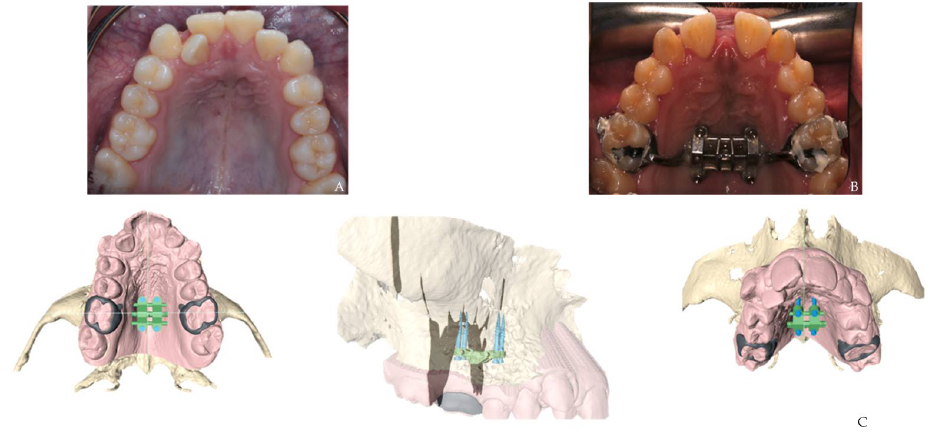
Figure 4. Planning the placement of micro-implants in the maxillary expander: Initial occlusal photo ( A ). Placement of the microimplant assisted rapid palatal expander ( B ). Microimplant place- ment planning through the superimposition of CBCT and digital models ( C